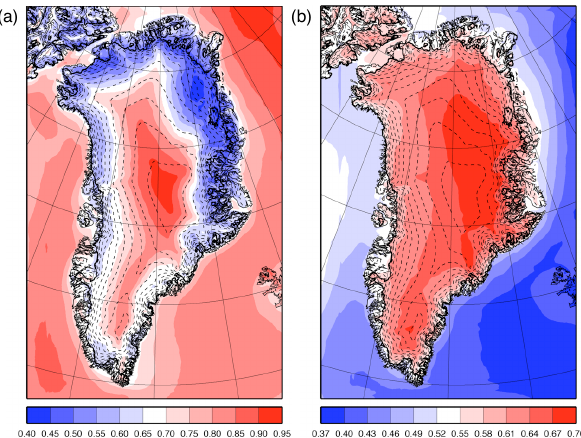
Fig. 8. Annual mean (a) surface albedo [ − ], and (b) net solar radi- ation [Wm − 2 ].